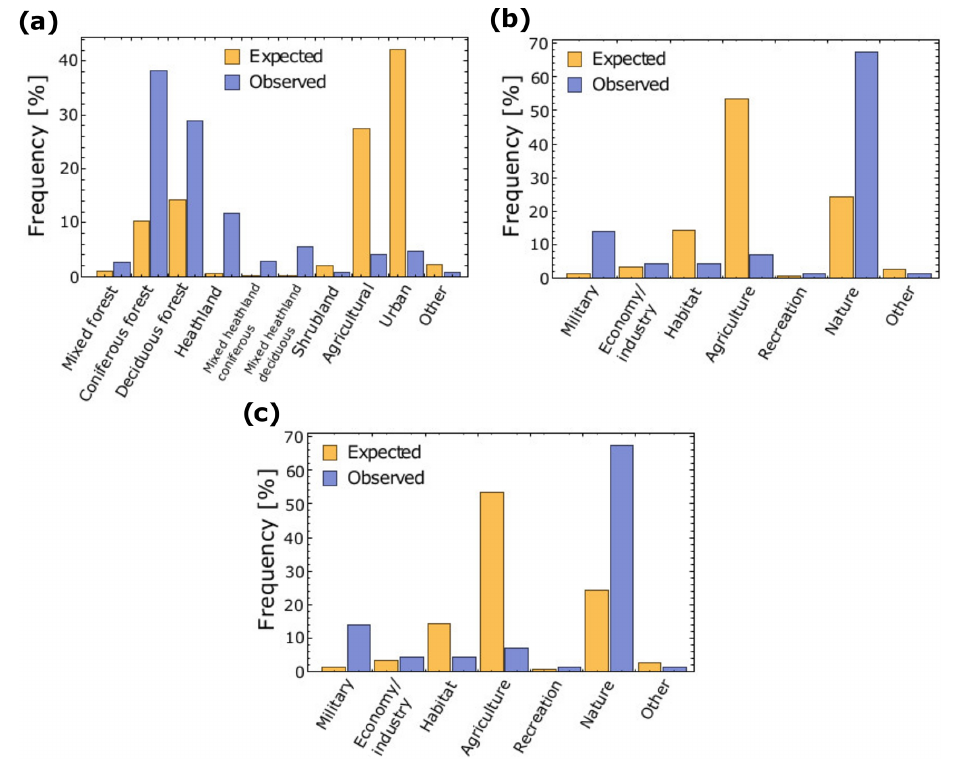
Figure 6. The expected and observed ignition frequency in relation to the distribution of the (a) land cover, (b) soil, and (c) land use classes. Table 2. The relative area (%) per ignition probability class for the Belgian provinces and the capital region of Brussels. Region Province Low Intermediate High Very high Flanders Antwerp 74.89 Flemish